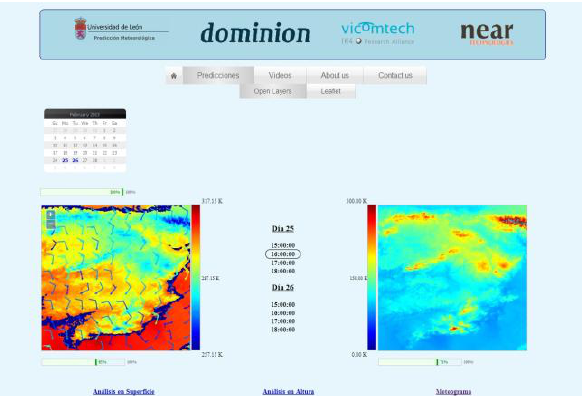
Figure 5. Client interface of the